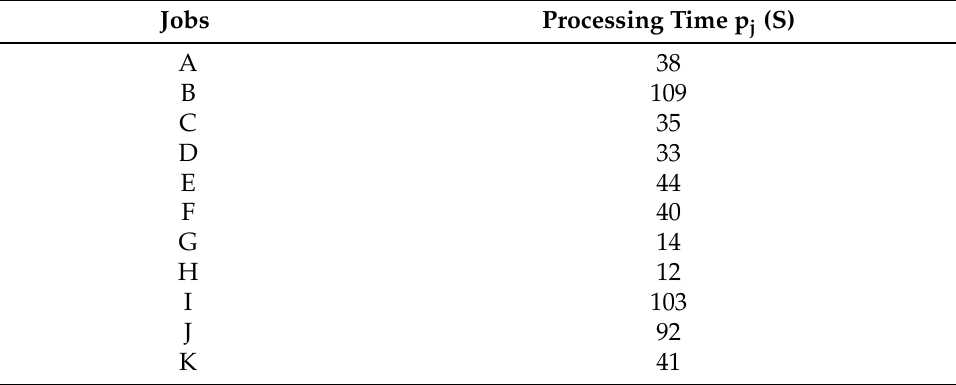
Table 2. Jobs and processing time.